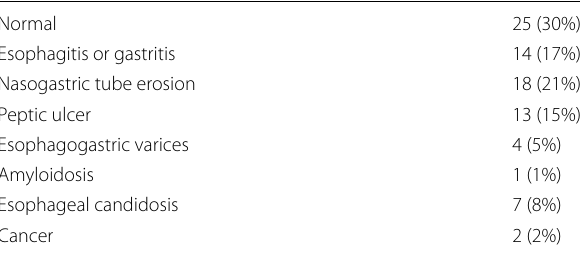
Table 3 Findings of the 84 upper